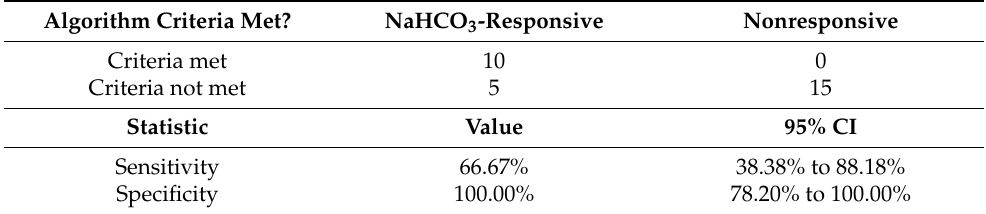
Table 2. Selected screening criteria for identifying NaHCO 3 -responsive and nonresponsive MRSA. Criteria are AMC susceptible, mecA “susceptible 2” genotype, spa type t008 or t002. Only strains meeting all three of these criteria are considered NaHCO 3 -responsive (Chi-squared and Fisher’s exact p <